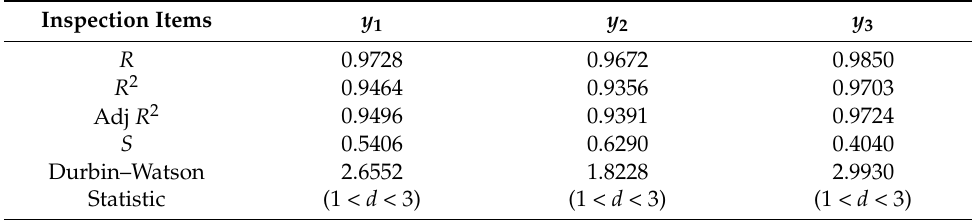
Table 7. Analysis of the significance of the regression coefficient on the test